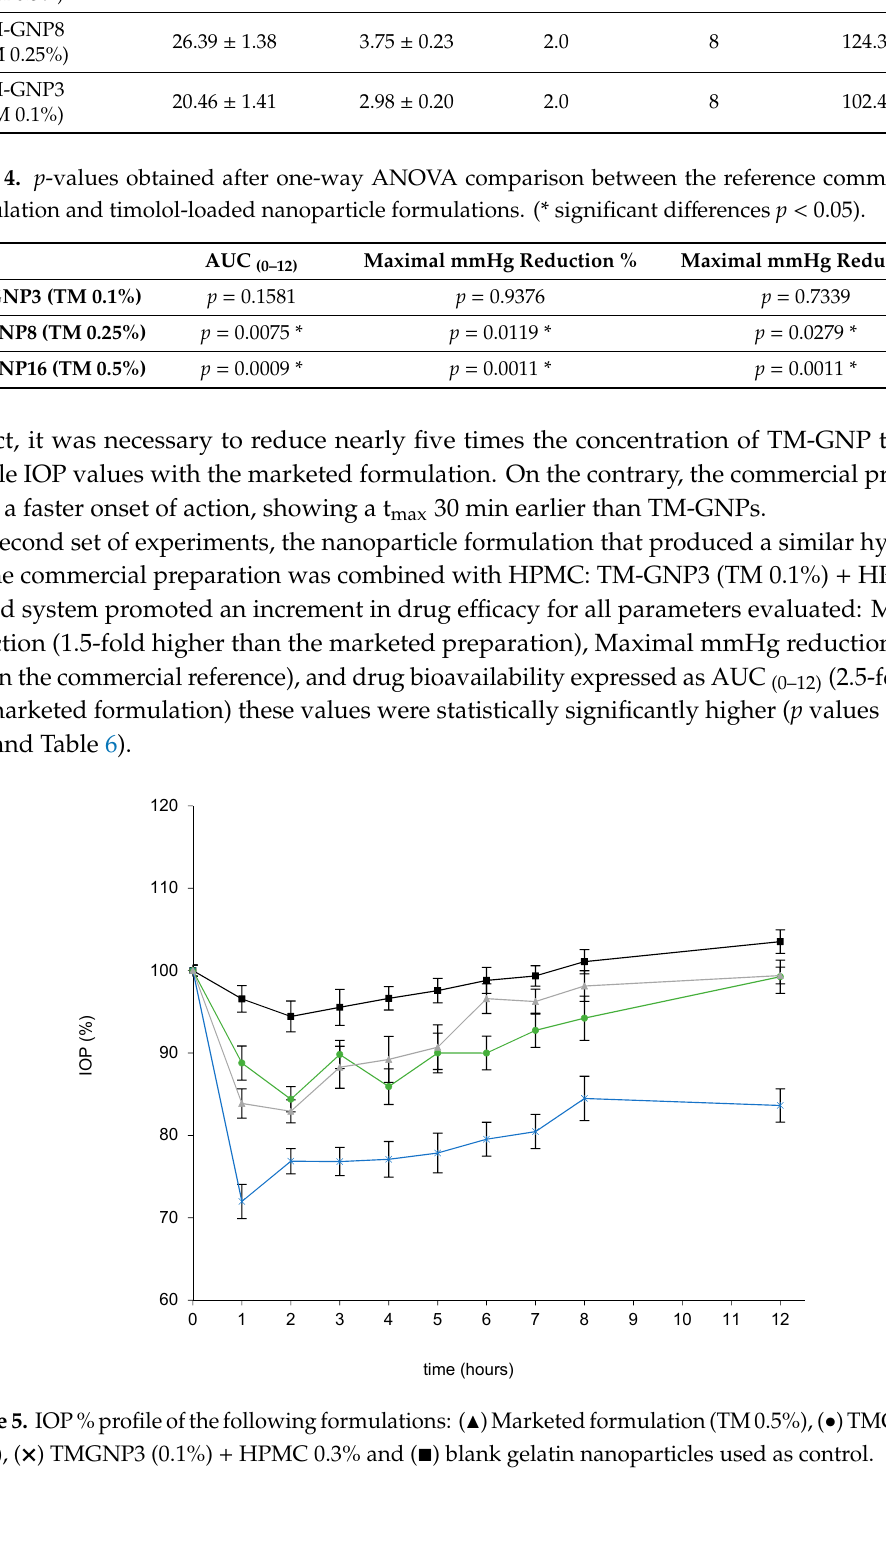
Table 3. Maximal % IOP reduction, Maximal mmHg reduction, t max , hypotensive e ff ect duration (hours) and the area under the curve AUC (0–12h) from the developed formulations. Maximal % Formulation IOP Reduction Marketed formulation (TM 0.5%)